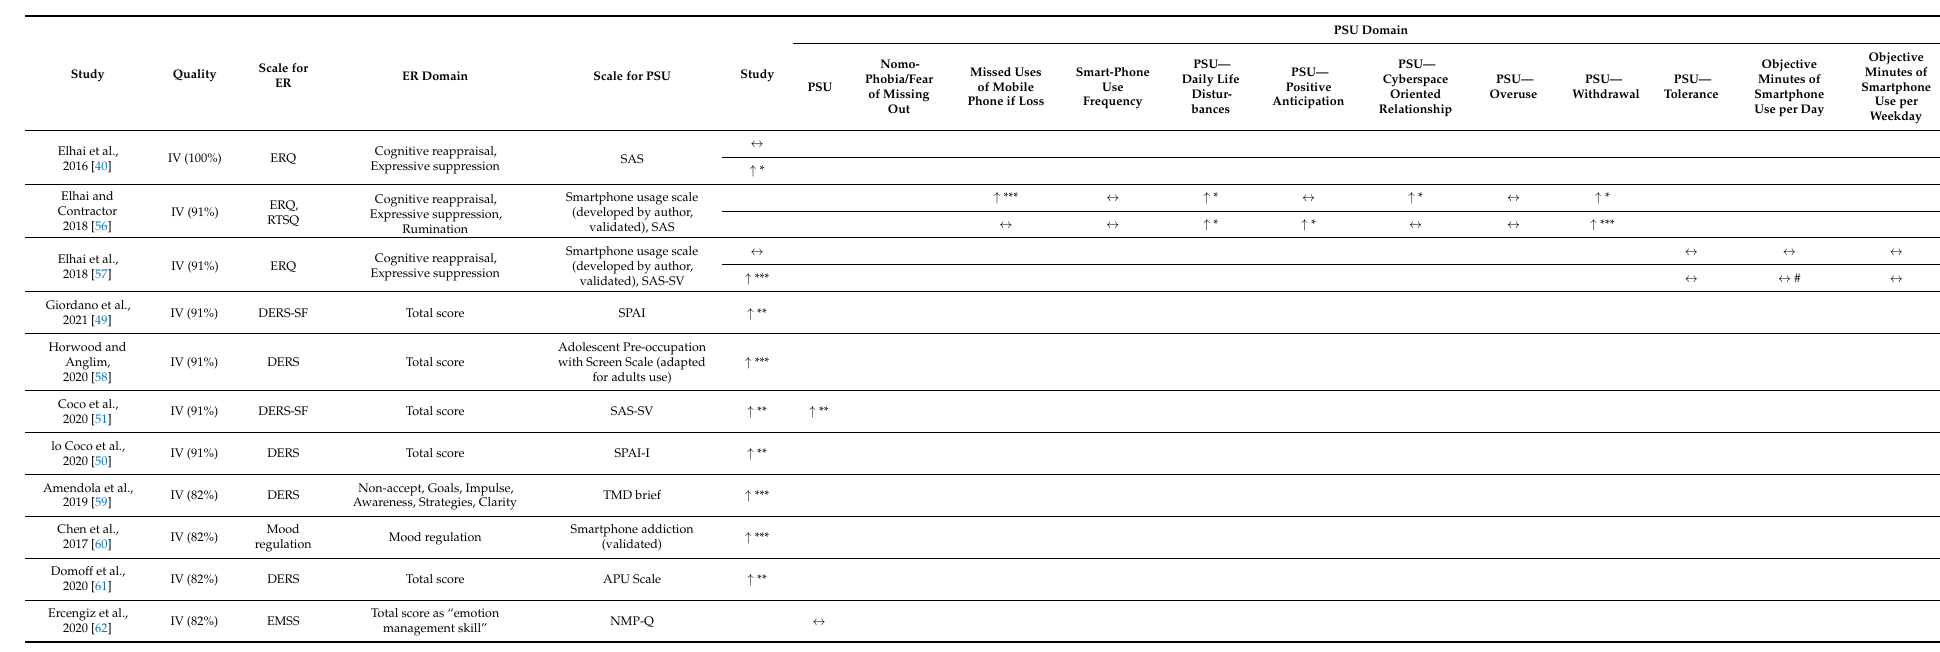
Table A2. Summary of ER on PSU domain